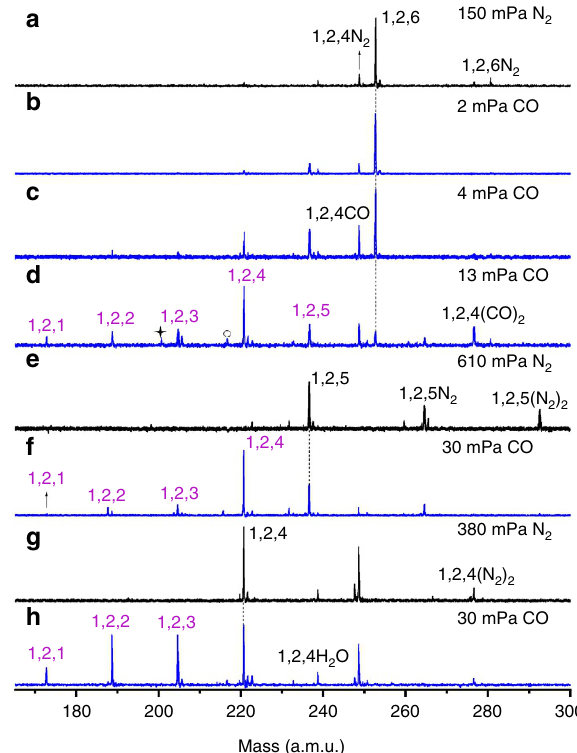
Figure 1 | Reactivity of RhAl 2 O 4–6 þ clusters with CO. Time-of-flight mass spectra for reactions of mass selected RhAl 2 O 4–6 þ with N 2 ( a , e , g ) and CO ( b – d , f , h ) are shown. Peaks marked with asterisk and hollow circle in d are CO adsorption products of RhAl 2 OCO þ and RhAl 2 O 2 CO þ , respectively. Rh x Al y O z þ and Rh x Al y O z X þ ( X ¼ N 2 , CO and H 2 O) species are labeled as x,y,z and x,y,zX , respectively. Signal 1,2,4H 2 O in h is due to the residual water in the gas handling system. The time periods for reactions RhAl 2 O 6 þ þ CO, RhAl 2 O 5 þ þ CO and RhAl 2 O 4 þ þ CO were about 1.1, 0.7 and 0.6ms, respectively. The reactant gas pressures are shown in mPa.